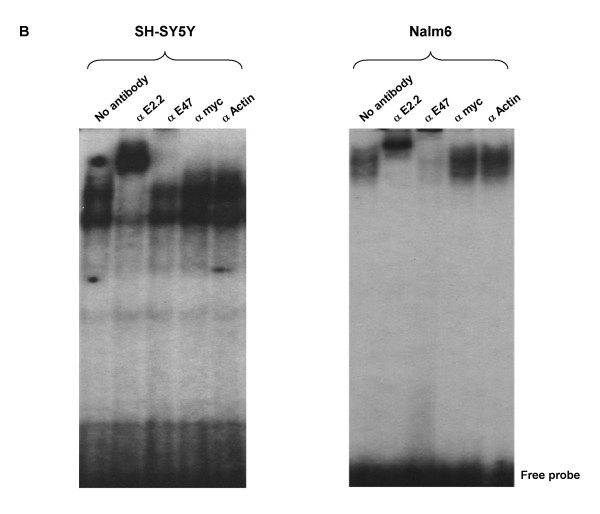
Neuroblastoma cells express variable levels of E-protein activity.  Panel (B) show a EMSA analysis where nuclear extracts from either SH-SY5Y  neuroblastoma or Nalm6 pre-B lymphoma cells were pre-incubated with either  no antibody, anti E2-2, anti E47, anti myc or anti actin antibody as  indicated.